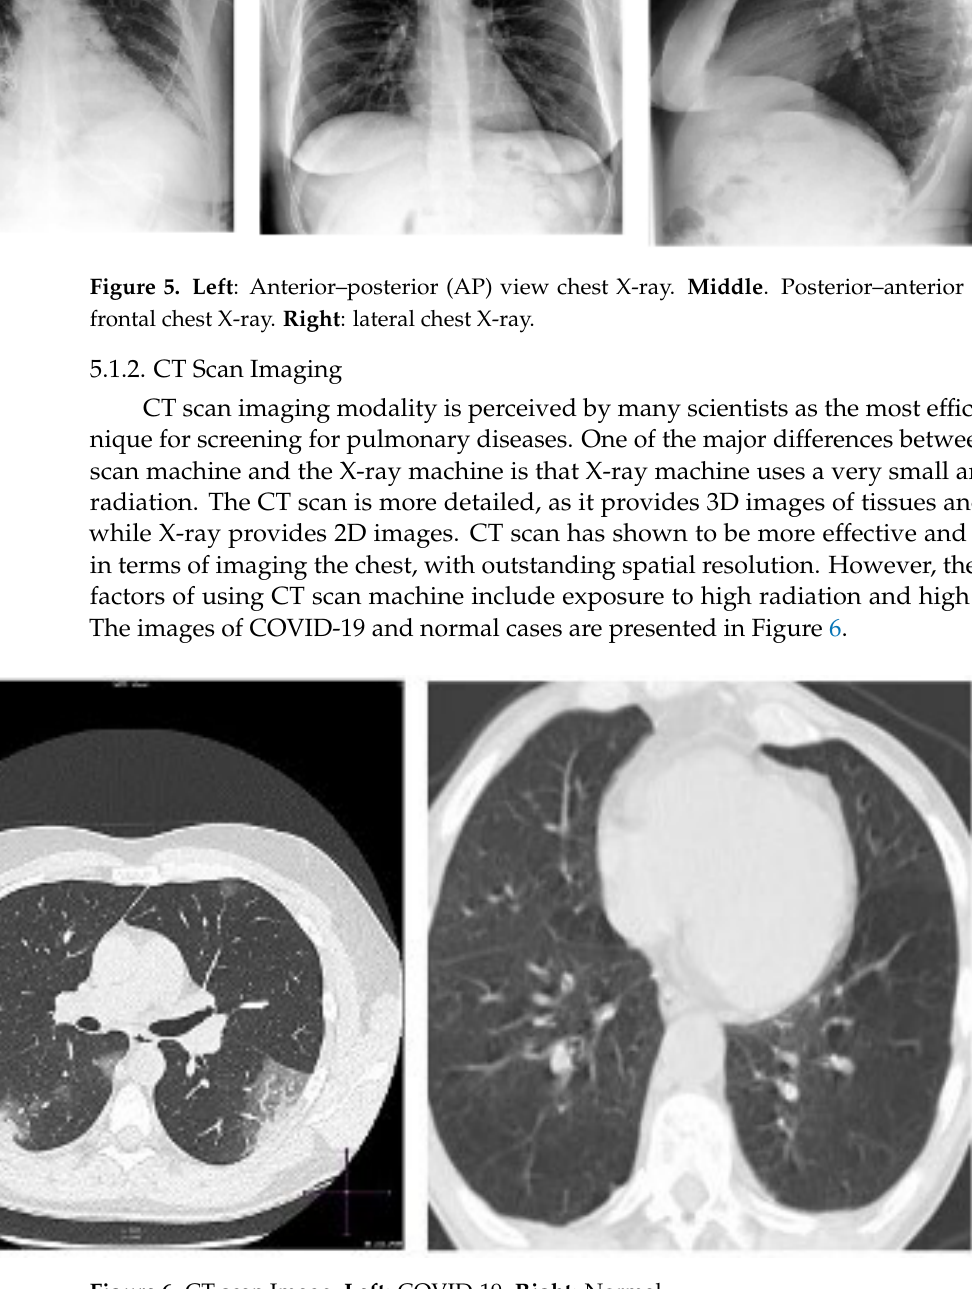
Figure 5. Left : Anterior–posterior (AP) view chest X-ray. Middle . Posterior–anterior (PA) view frontal chest X-ray. Right : lateral chest X-ray.